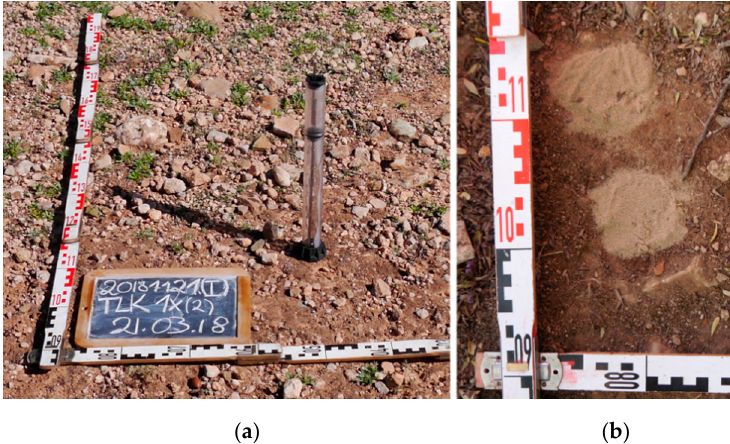
Figure 5. ( a ) Minidisk infiltrometer; ( b ) plot record after the experiment, with a thin layer of fine sand added for improved hydraulic connection .